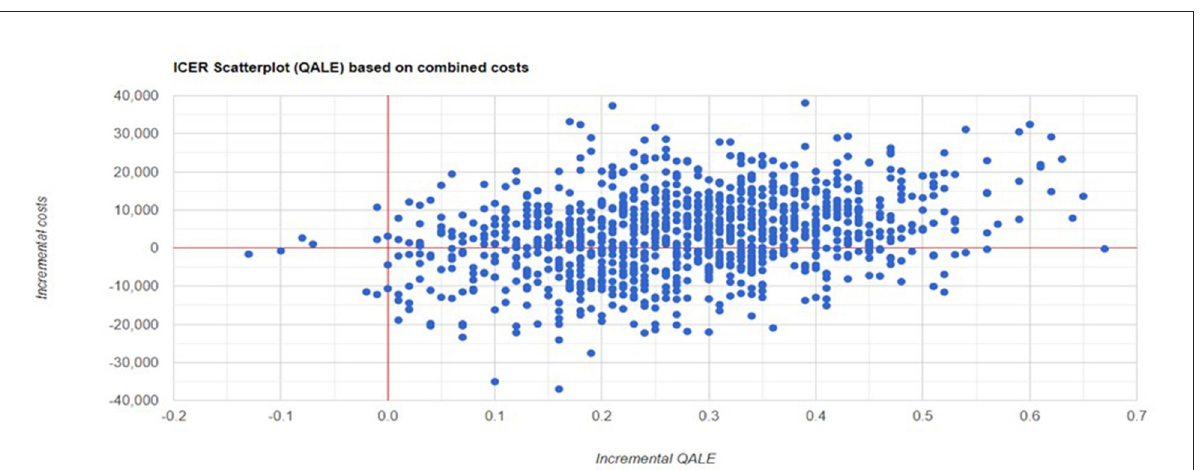
FIGURE1 Scatter plots for probability sensitivity analyses.